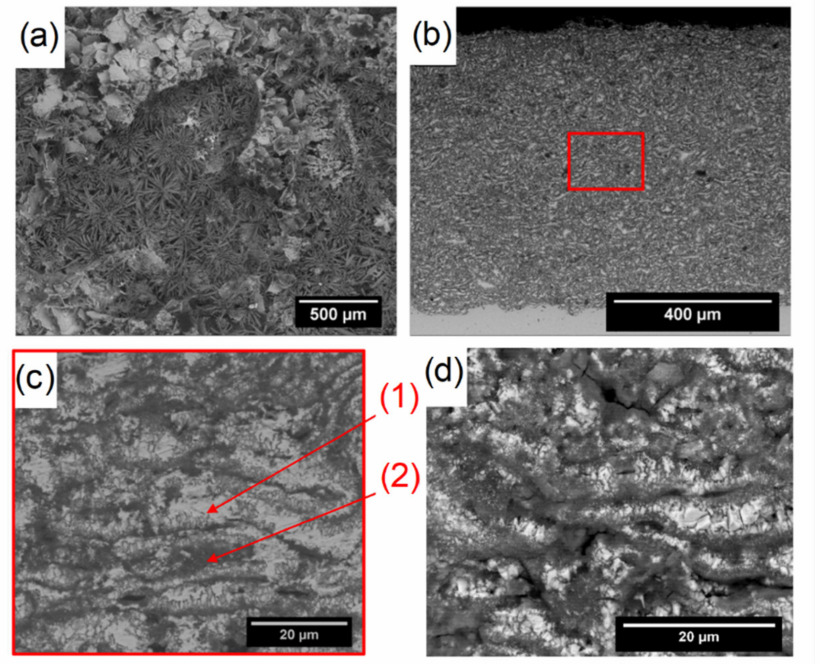
Figure 12. SEM observations of surface ( a ) and cross-section obtained by wire sawing ( b , c ) or freeze-fracturing ( d ) of a Zn-15wt.%Al coating after the 6-month galvanic corrosion experiment. (1) and (2) = zones analyzed by EDS (see